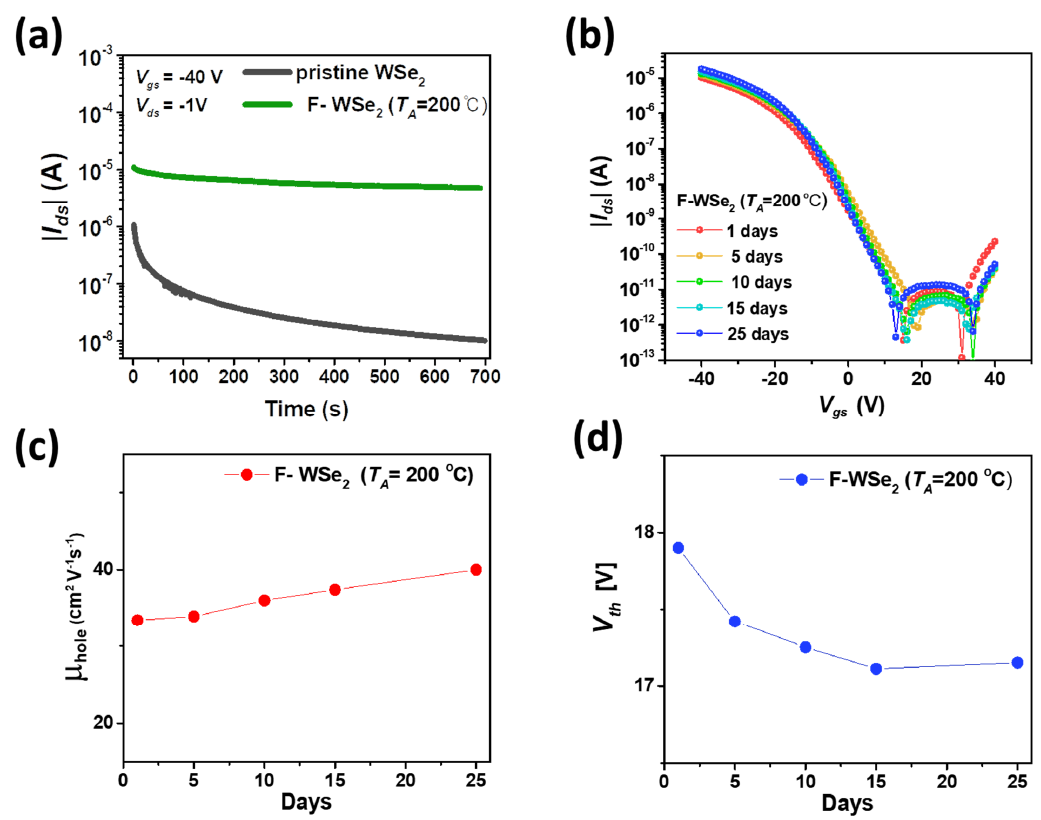
Figure 7. Stability test of F-WSe 2 . ( a ) Reduction in bias stress due to passivation effect due to Cytop doping. ( b ) F-WSe 2 ( T A = 200 °C) transfer characteristics of the device with increasing time stored in air at room temperature. All electrical characteristics were measured in air. ( c ) Threshold voltage and ( d ) hole mobility change of F-WSe 2 device annealed at T A = 200 °C after Cytop doping for 25 d in air.